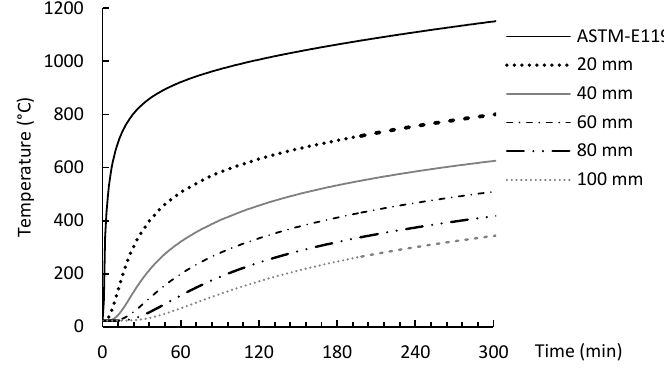
Figure 2. Temperature predictions at different concrete depths vs. exposure